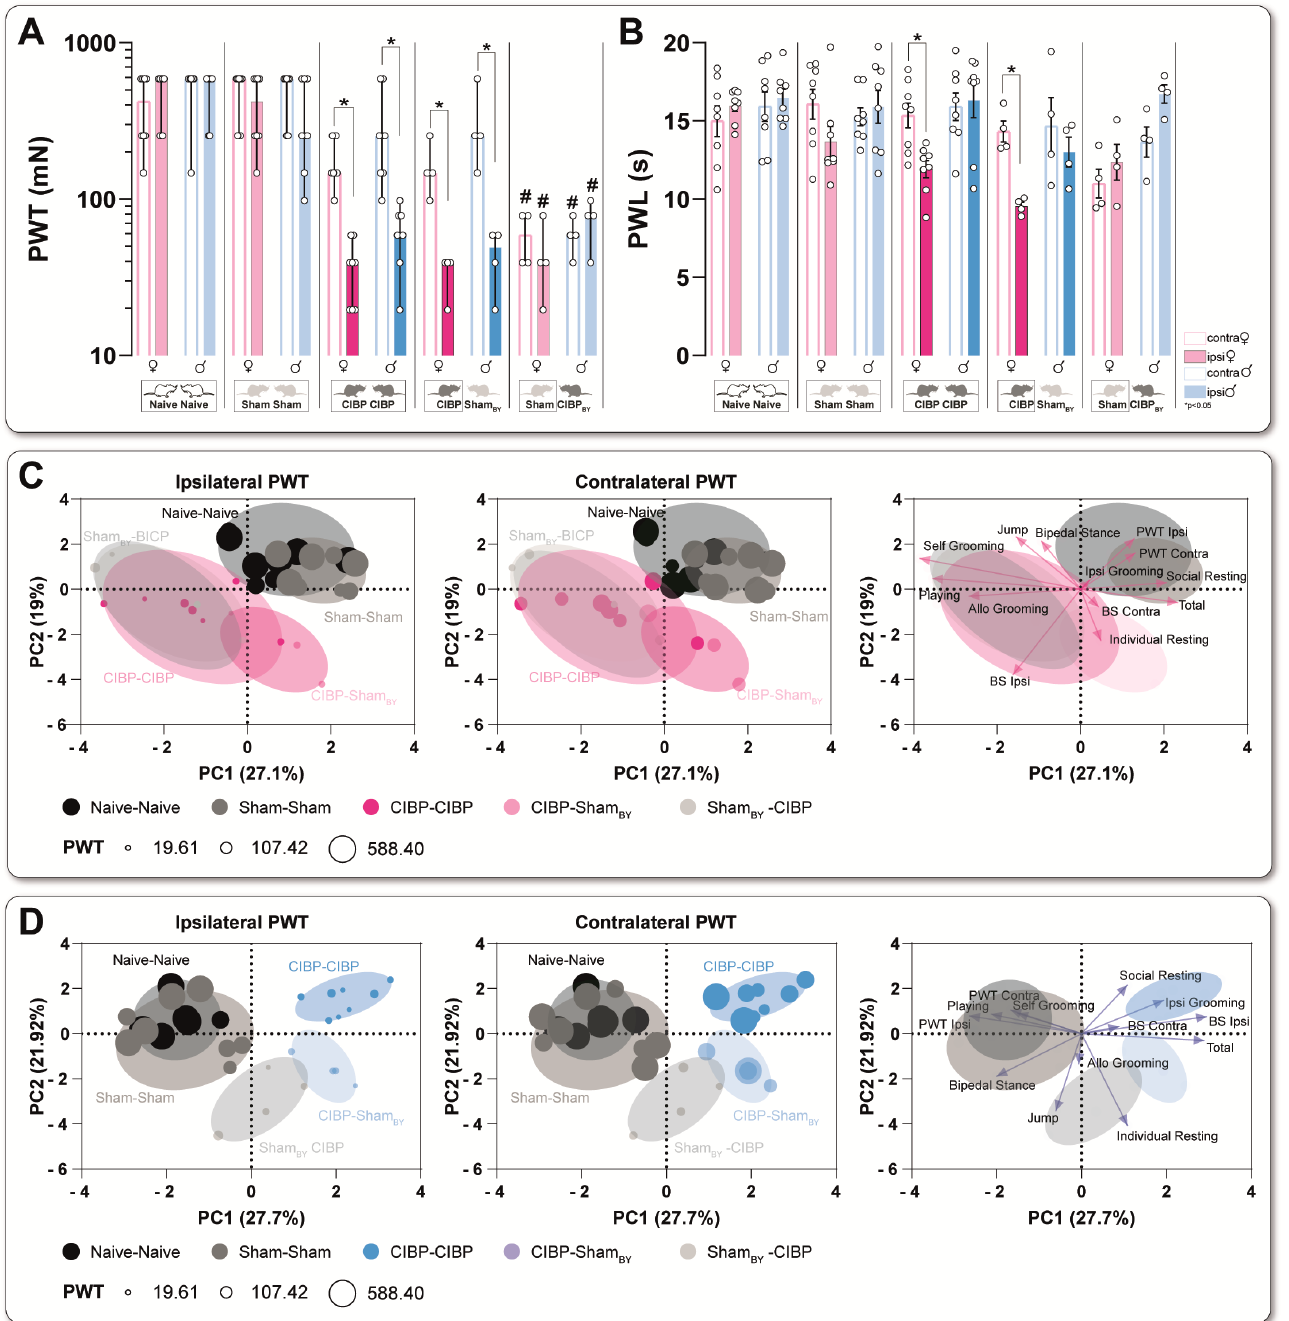
Figure 5. Social transfer of pain-related behavior to sham bystander (BY) rats caused by cancer- induced bone pain in both sexes ( A ) Mechanical (PWT) and heat (PWL) ( B ) thresholds of the ipsilateral versus contralateral hind paws in rats of both sexes in four different housing conditions 17 d after cell innoculation. ( C , D ) Representative visualization of the principal component analysis of female ( C ) and male ( D ) rats, including home-cage parameter, bone score, and mechanical threshold (PWT) of both hind paws at 17 d. The bubble size represents the PWT. Four different housing combinations are shown here. Each housing combination was repeated four times with other animals ( n = 8, Naïve; n = 8 sham; n = 8 CIBP; n = 4 CIBP-shamBY; n = 4 shamBY-CIBP). Boxes represent the data shown. Results are expressed as mean ± SEM. Two-way ANOVA (repeated measures based on GLM) followed by Dunnett’s multiple comparison test * for comparison to the contralateral site; p -Values: * ≤ 0.05, # for comparison to sham-sham; p -values: # ≤